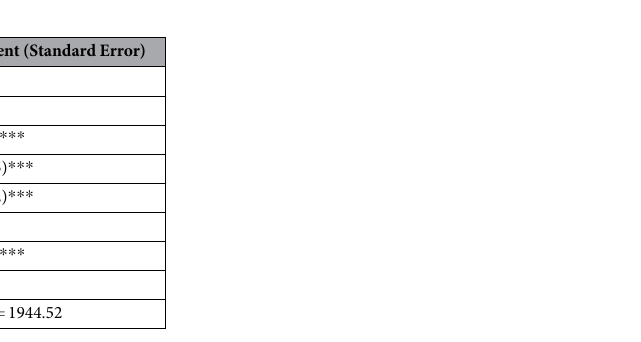
Across populations, the positive correlation between the log-transformed number of children and WHR was statistically significant and robust ( r = 0.40, p < 0.001). A similar effect was observed when the raw number of children was used ( r = 0.39, p < 0.001). To test whether direction and strength of the effect were similar across populations, we analyzed this relationship with the use of multilevel regressions. As a subsample of Indonesians from Sulawesi was quite small in comparison with other populations, in this study we repeated our multilevel regression analyses without and with Indonesians. As the pattern of results was almost exactly the same, we decided to focus on estimates obtained on the entire sample (including Indonesians). Before analysis, we stand- ardized ( z -scored) the dependent variable (WHR), the predictor (the log-transformed number of children), and control variables: BMI and age in a way that all of our individual level variables had a mean of 0 and a standard